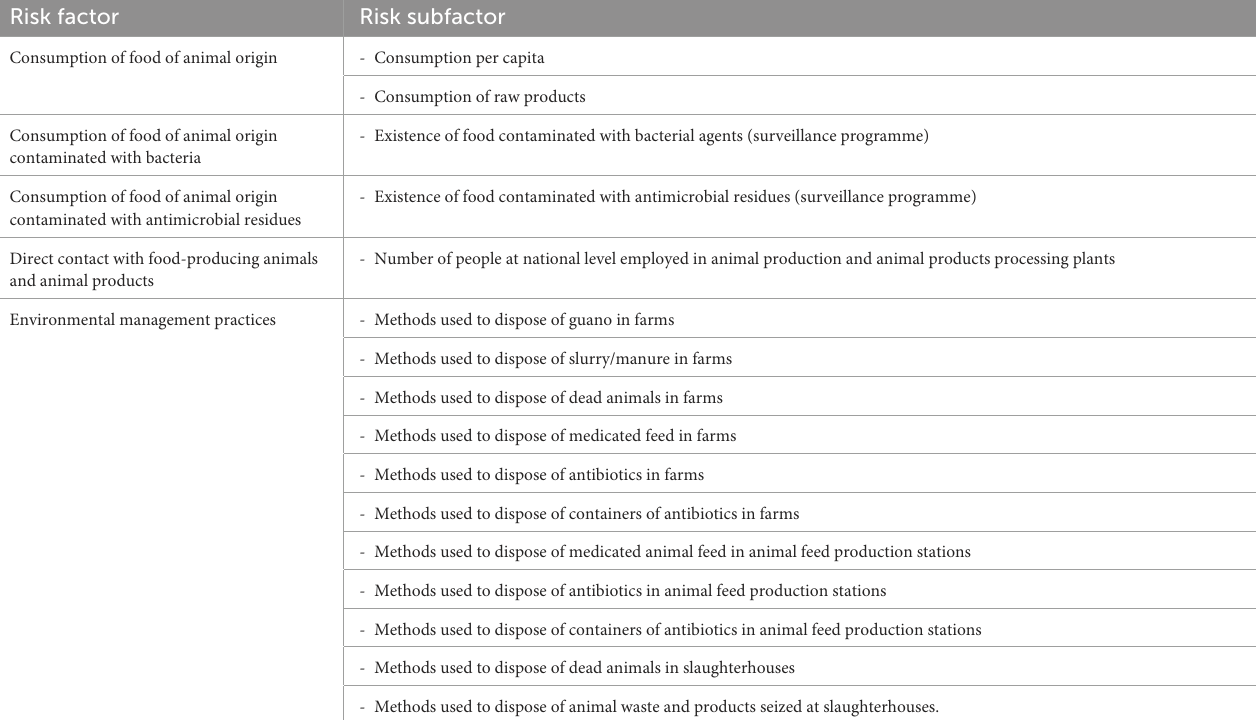
TABLE 3 AMR exposure risk factors and subfactors for human health.